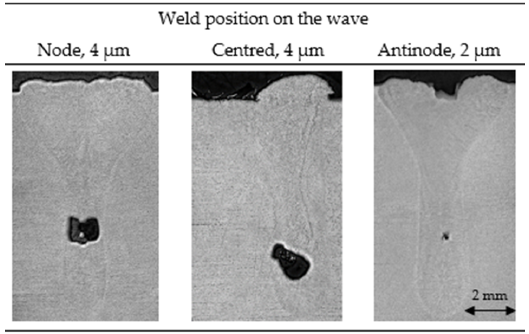
Figure 6. Exemplary micrographs of metallographic cross sections of welding seams (Material 2.4856) regarding porosity shape.